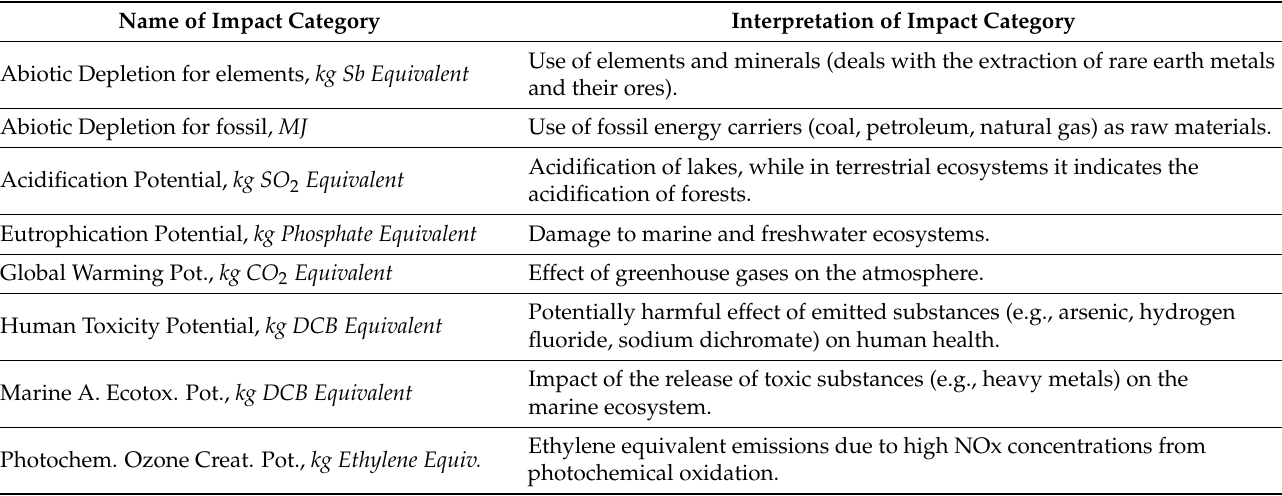
Table 1. The examined environmental impact categories in different equivalents